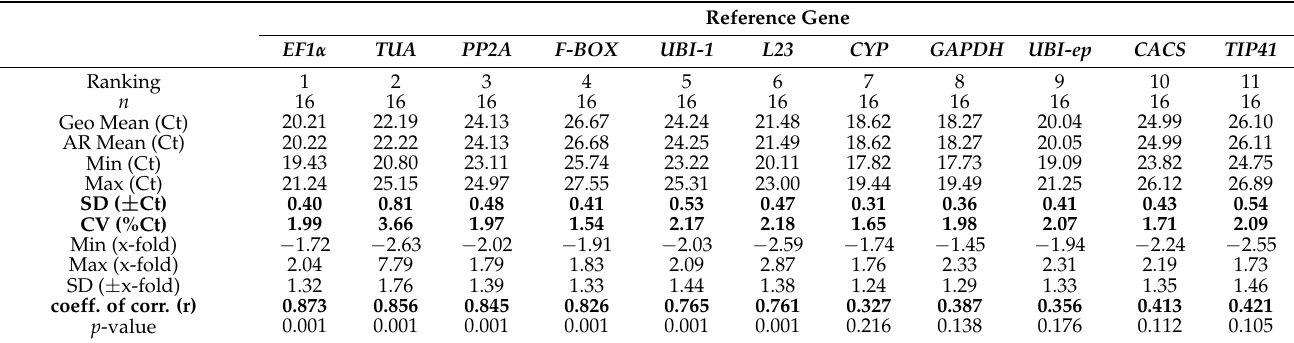
Table 3. Descriptive statistics of the eleven candidate reference genes by Bestkeeper analysis. n : number of samples; Geo Mean (Ct): geometric mean of Ct value; AR mean (Ct): arithmetic mean of Ct value; Min and Max (Ct): extreme values of Ct; SD: standard deviation; CV: coefficient of variation; Min and Max (x-fold): extreme values of expression levels; SD ( ± x-fold): standard deviation of the absolute regulation coefficients; r: coefficient of